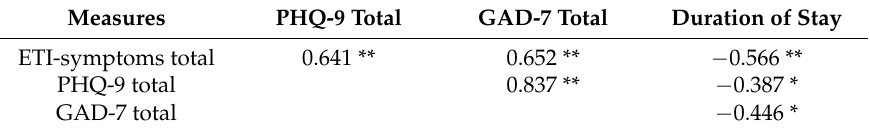
Table 6. Pearson’s correlations between